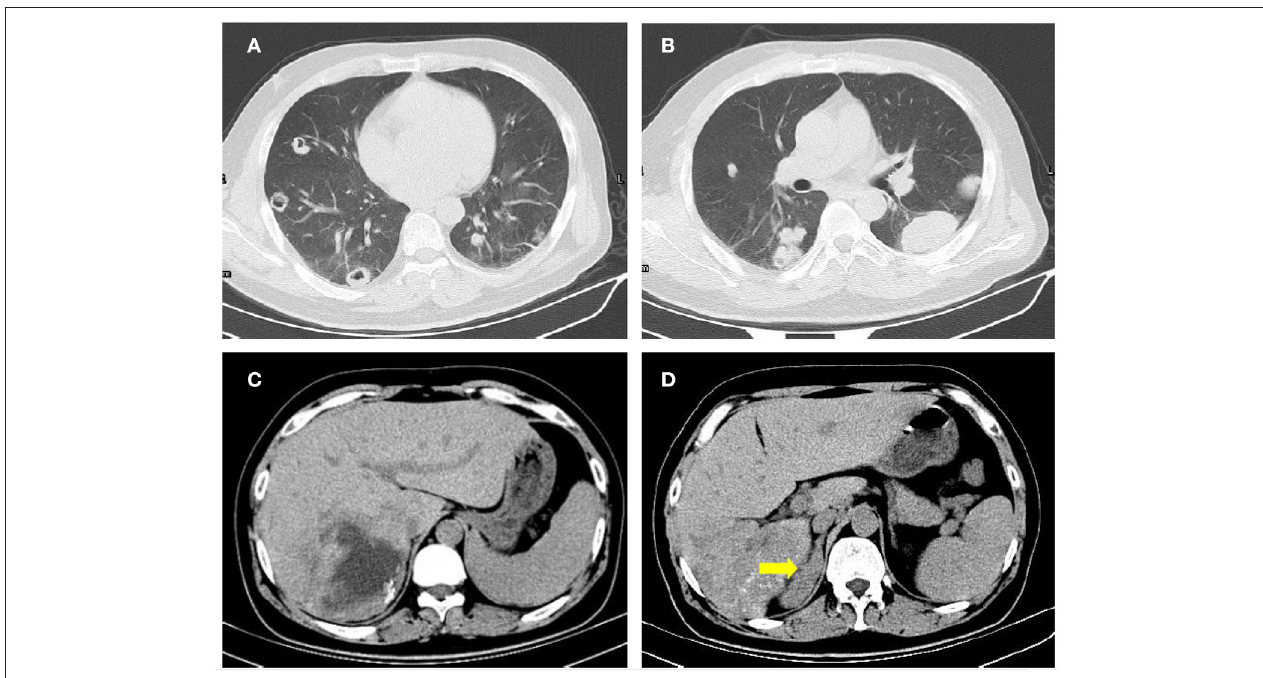
FIGURE 2 | Lung and abdominal CT images of the patient. Multiple Lesions were found in bilateral lung (A,B) and the liver (C) . The right adrenal gland (yellow arrow) was obviously thickened (D) .